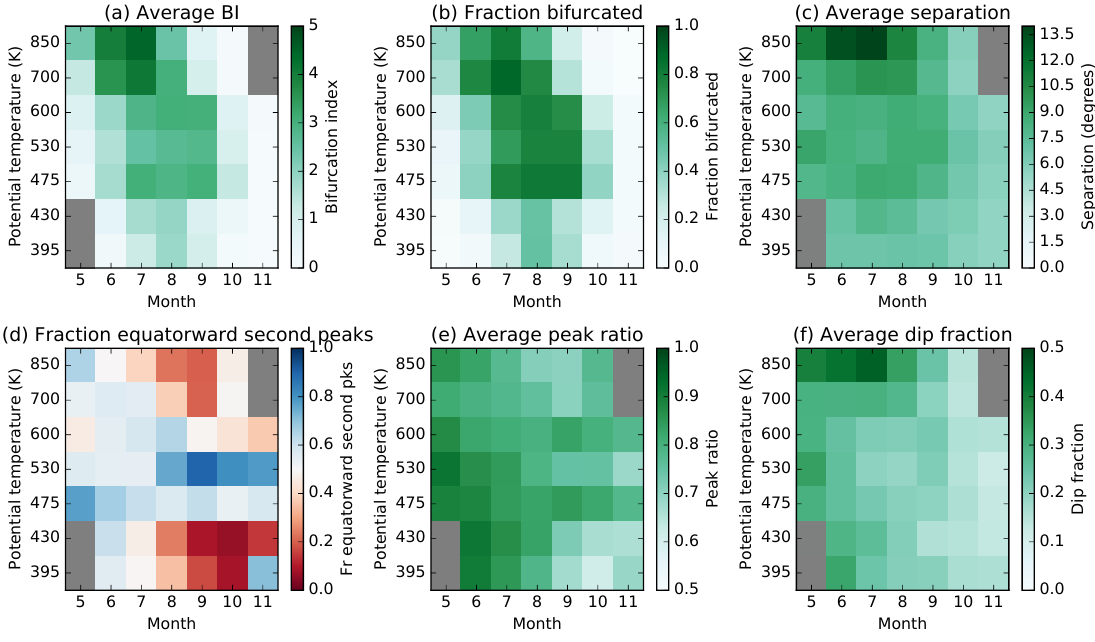
Figure 4. Climatological structure and seasonal evolution of bifurcation metrics derived at ERA-Interim levels between 395 and 850K, 1979–2016. Months/levels with less than 1% of bifurcated profiles are shaded in grey.